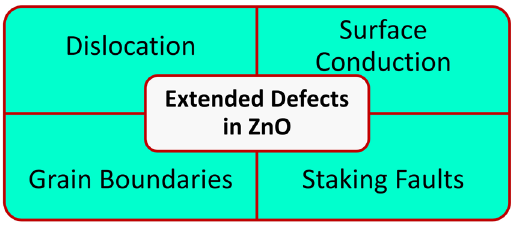
Figure 16: Di ff erent types of extended